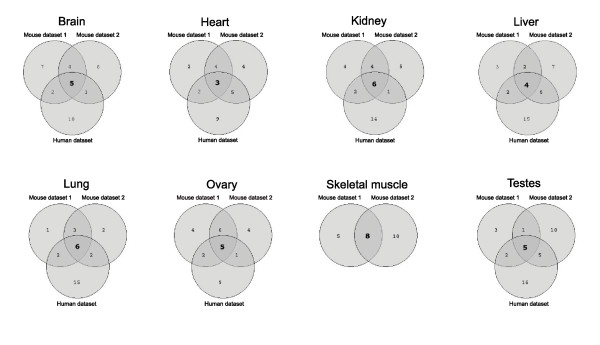
Correlation between miRNA signatures detected in two mouse and one human gene expression datasets. Results from eight tissues are presented (no suitable human skeletal muscle expression data were available) in separate Venn diagrams. Each circle in the Venn diagrams indicates the number of miRNAs with significantly low target gene expression in two mouse (top) and one human (bottom) mRNA expression datasets. The number of miRNAs common between all datasets in each tissue is indicated in bold.